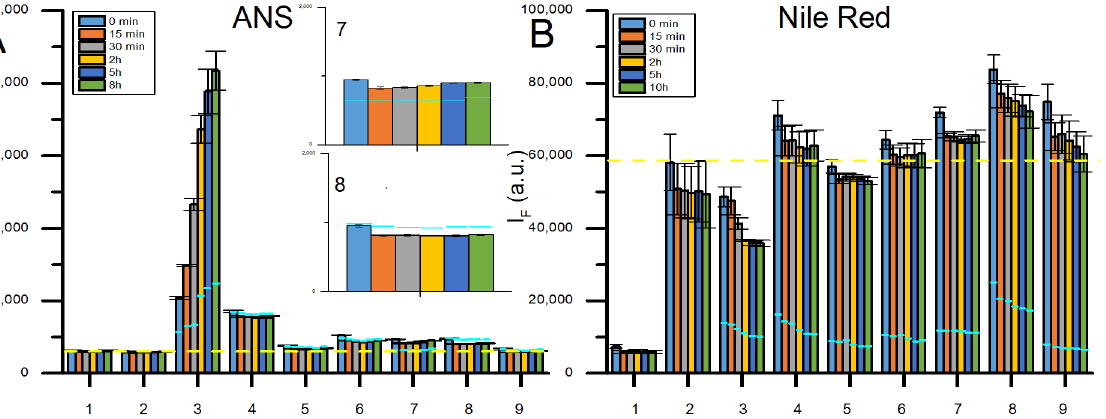
Fig 3. Screening results for 7 proteins and PS-COOH, ANS data in panel A and NR data in panel B, with corresponding controls. Bars represent the mean intensity value from three individual samples, with standard deviation in corresponding error bars, at 6 different time points; 0 min (blue), 15 min (red), 30 min (gray), 2 h (yellow), 5 h (dark blue) and 8 h (green) for the ANS data and 10 h (green) for the NR data. Fluorescence intensity of fluorophore with 1: Buffer only, 2: Particle only, 3: Lysozyme + particle, 4: HSA + particle, 5: OVA + particle, 6: CA-I + particle, 7: trCA-II + particle, 8: β -lactoglobulin + particle, 9: Calbindin + particle. Sky blue lines show the protein controls (i.e. protein with fluorophore) I F at each time point. In both panels a yellow dashed line is drawn across all samples representing the mean fluorescence from the particle control at time point 0 min. In panel A, two insets are also shown for trCA-II (number 7) and for β -lactoglobulin(number 8)